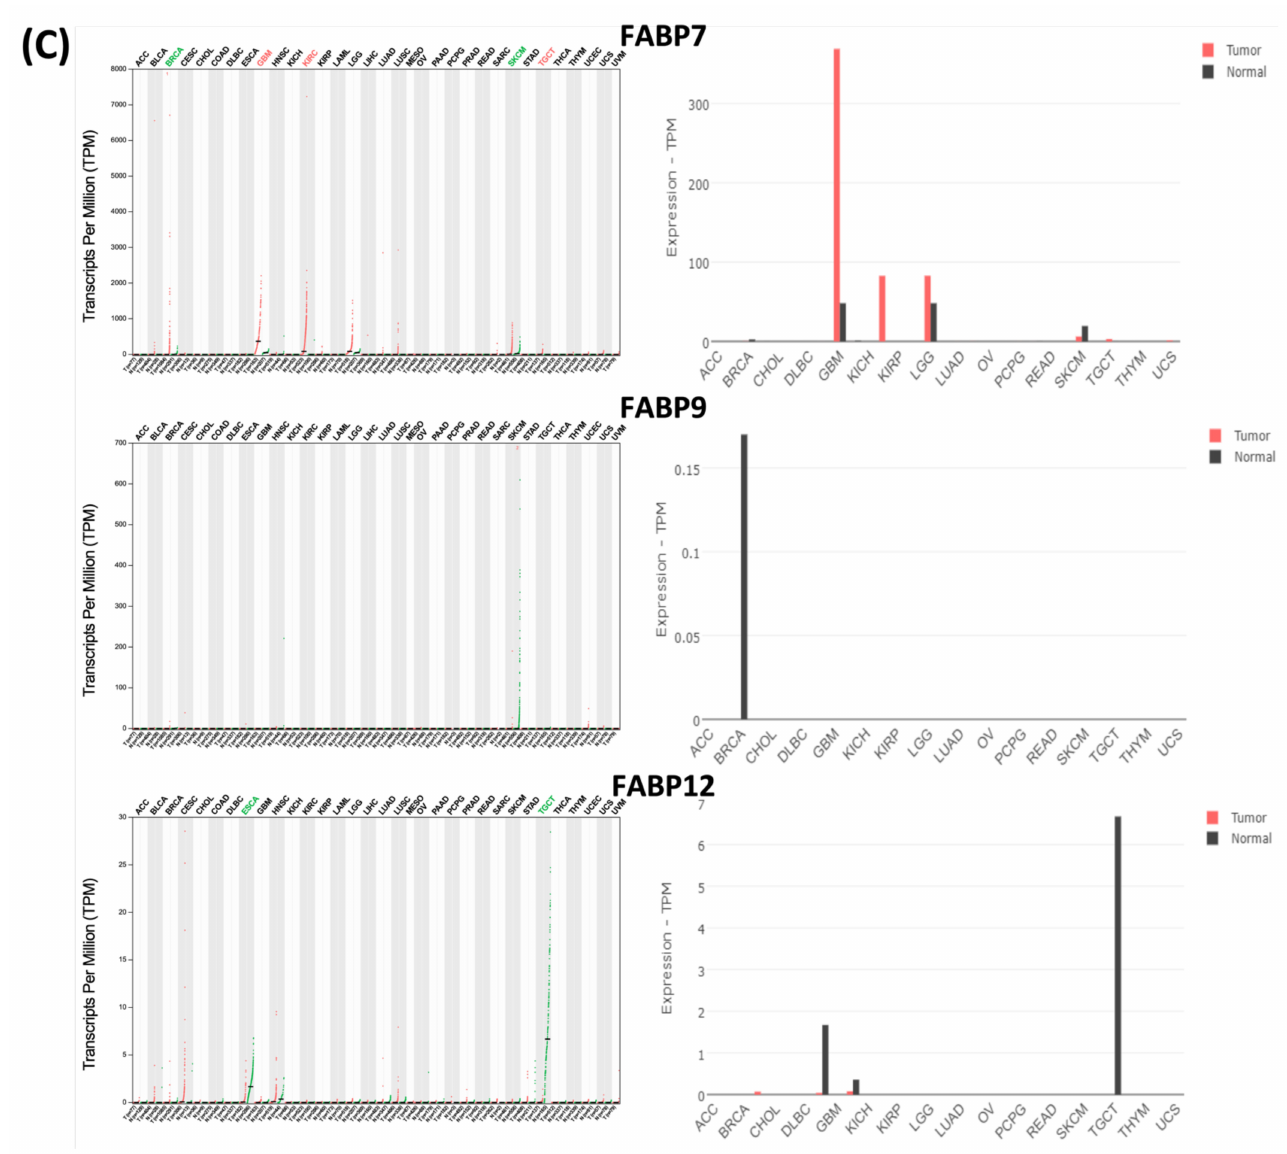
Figure 3. The gene expression profile of fatty acid-binding proteins ( FABP s) ( A ) FABP1, FABP2 and FABP3; ( B ) FABP4, FABP5 and FABP6; ( C ) FABP7, FABP9 and FABP12 across 27 TCGA tumor samples and paired normal tissues using GEPIA (Gene Expression Profiling Interactive Analysis) webserver. The red bar indicates the expression of FABP genes in tumor tissues, while black indicates the expression in normal tissues. For each TCGA tumor (red), its matched normal and GTEx data (green) are given; T: tumor; N: normal; n: number. Y axis: transcript per million (log2(TPM + 1)). X axis: number of tumor and normal samples. ACC, adrenocortical carcinoma; BLCA, bladder urothelial carcinoma; BRCA, breast invasive carcinoma; CESC, cervical squamous cell carcinoma and endocervical adenocarcinoma; CHOL, cholangiocarcinoma; COAD, colon adenocarcinoma; DLBC, lymphoid neoplasm diffuse large B-cell lymphoma; ESCA, esophageal carcinoma; GBM, glioblastoma multiforme; HNSC, head and neck squamous cell carcinoma; KICH, kidney chromophobe; KIRC, kidney renal clear cell carcinoma; KIRP, kidney renal papillary cell carcinoma; LAML, acute myeloid leukemia; LGG, brain lower-grade glioma; LIHC, liver hepatocellular carcinoma; LUAD, lung adenocarcinoma; LUSC, lung squamous cell carcinoma; MESO, mesothelioma; OV, ovarian serous cystadenocarcinoma; PAAD, pancreatic adenocarcinoma; PCPG, pheochromocytoma and paraganglioma; PRAD, prostate adenocarcinoma; READ, rectum adenocarcinoma; SARC, sarcoma; SKCM, skin cutaneous melanoma; STAD, stomach adenocarcinoma; TGCT, testicular germ cell tumors; THCA, thyroid carcinoma; THYM, thymoma; UCEC, uterine corpus endometrial carcinoma; UCS, uterine